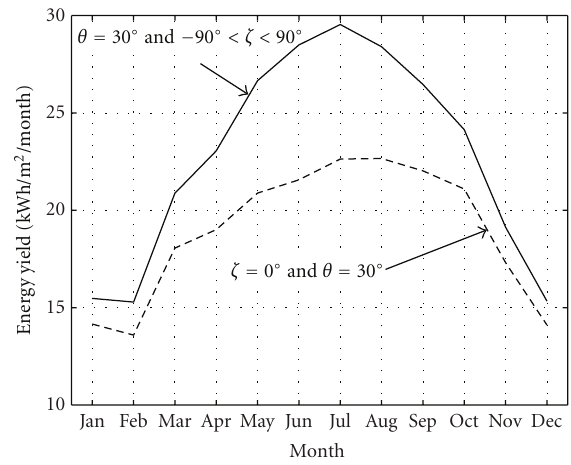
Figure 7: Energy yield of fixed (fixing both ζ and θ ) and one-axis (fixing θ and varying ζ ) PV systems for each month. The maximum energy yield occurs in also July for both curves. The gain of such tracking over the fixed one is